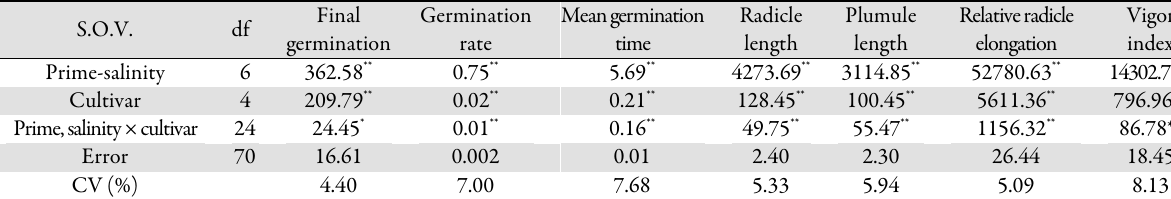
Table 1. ANOVA analysis showing the germination parameters of the studied traits S.O.V.